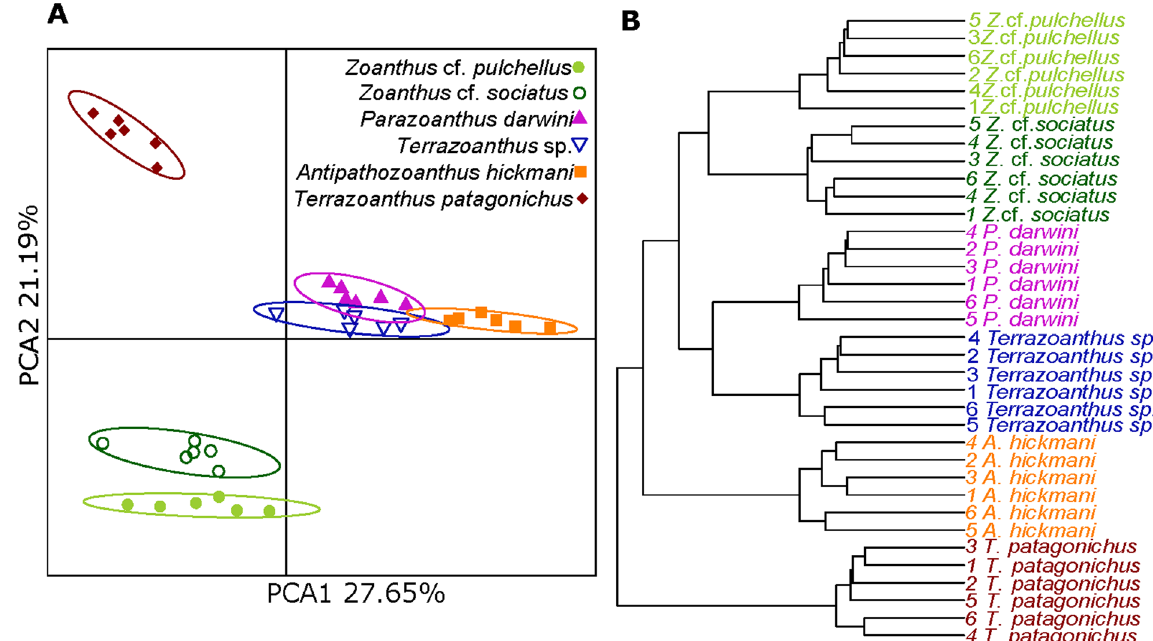
Figure 3. Untargeted Metabolomic Analysis of Zoantharians from this study. Score plots of metabolomic profiles of Antipathozoanthus hickmani , Parazoanthus darwini , Terrazoanthus patagonichus , Terrazoanthus sp., Zoanthus cf. pulchellus , and Zoanthus cf. sociatus . The explained variances are shown in brackets. ( A ) Principal Component Analysis. ( B ) Hierarchical Cluster